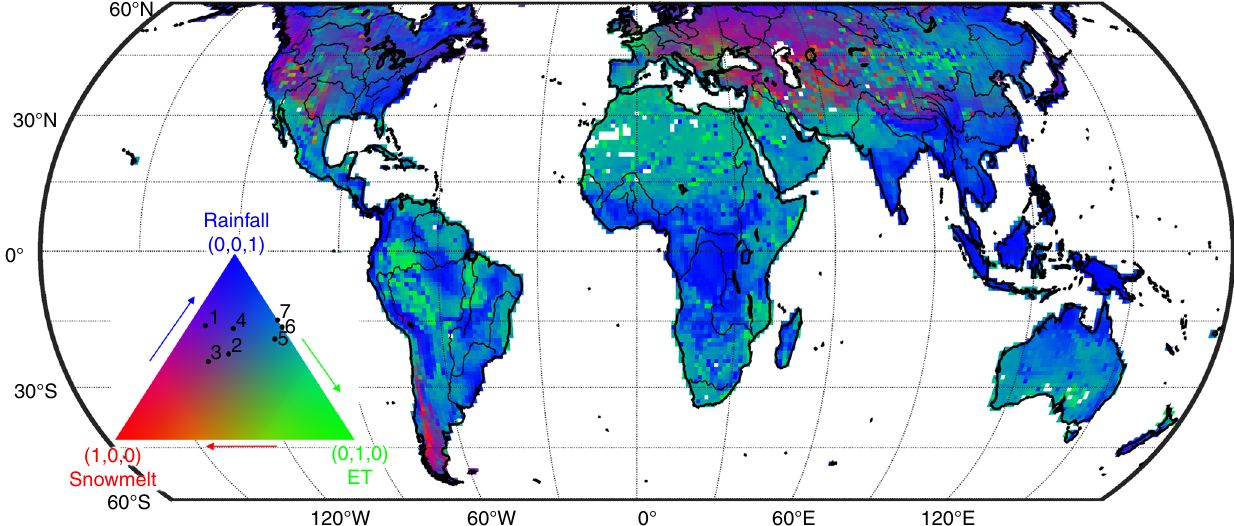
Fig. 3 Attribution of future groundwater recharge. Attribution of future groundwater recharge to three climate-driven factors (rainfall, snowmelt, and evapotranspiration (ET)), as derived from the regression based on CESM-LE projections (2006 − 2010) under the business-as-usual scenario (RCP8.5). The color in the triangle quanti fi es the relative contribution of each factor based on relative hue in red (snowmelt), green (ET), and blue (rainfall). Aquifer- averaged results are labeled on the triangle using the aquifer index shown in Fig. 2. For example, the results of Guarani (6) is snowmelt: 0.0, ET: 0.4, rainfall:0.6. Three contributions are separated and shown in Supplementary Fig. 11 in a single-color